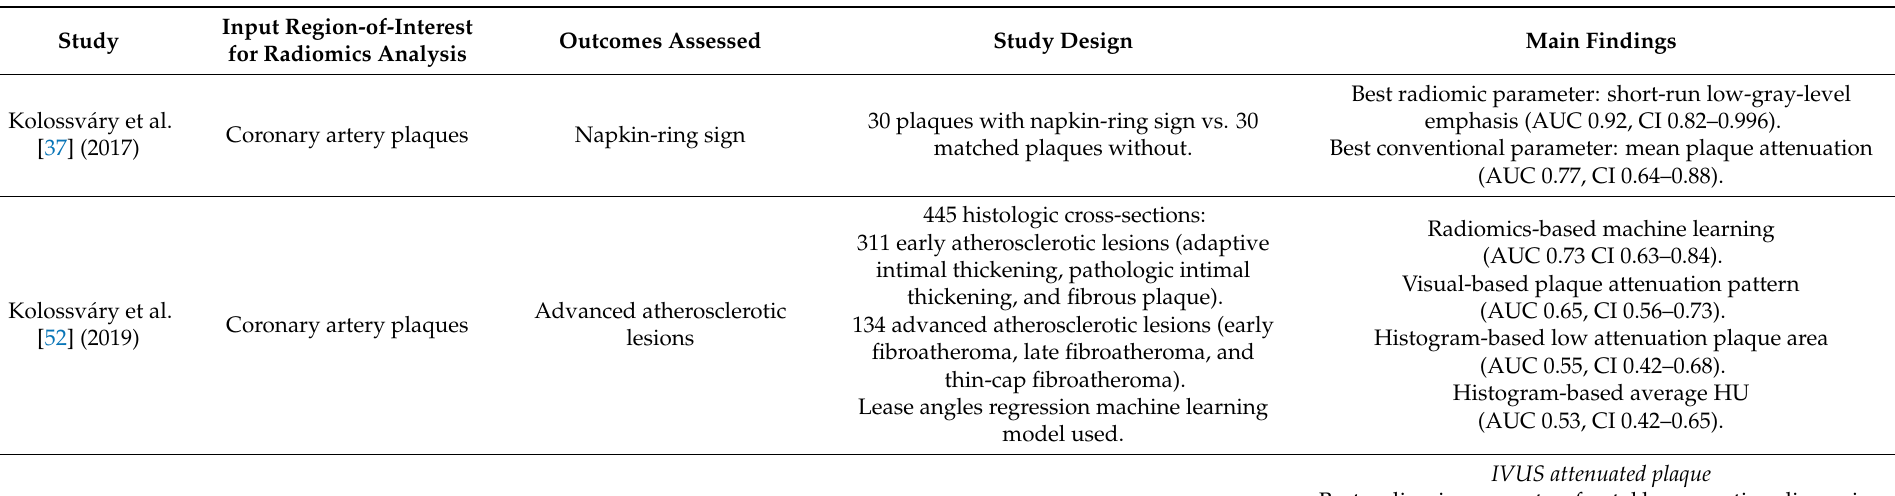
Table 2. Studies examining the relationship between CT-derived radiomics parameters of coronary plaques and PCAT with coronary